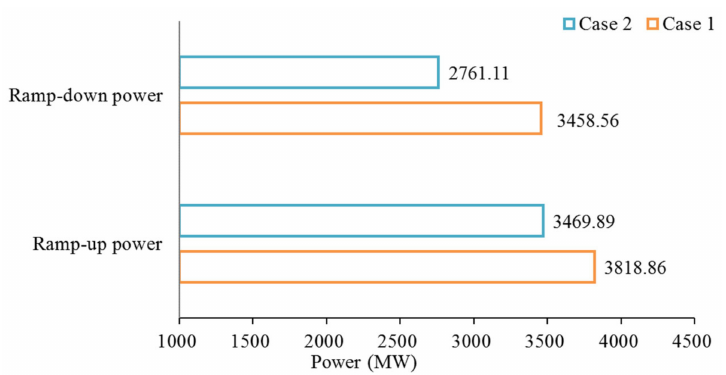
Figure 16. The ramp-up and ramp-down power of Case 1 and Case 2.